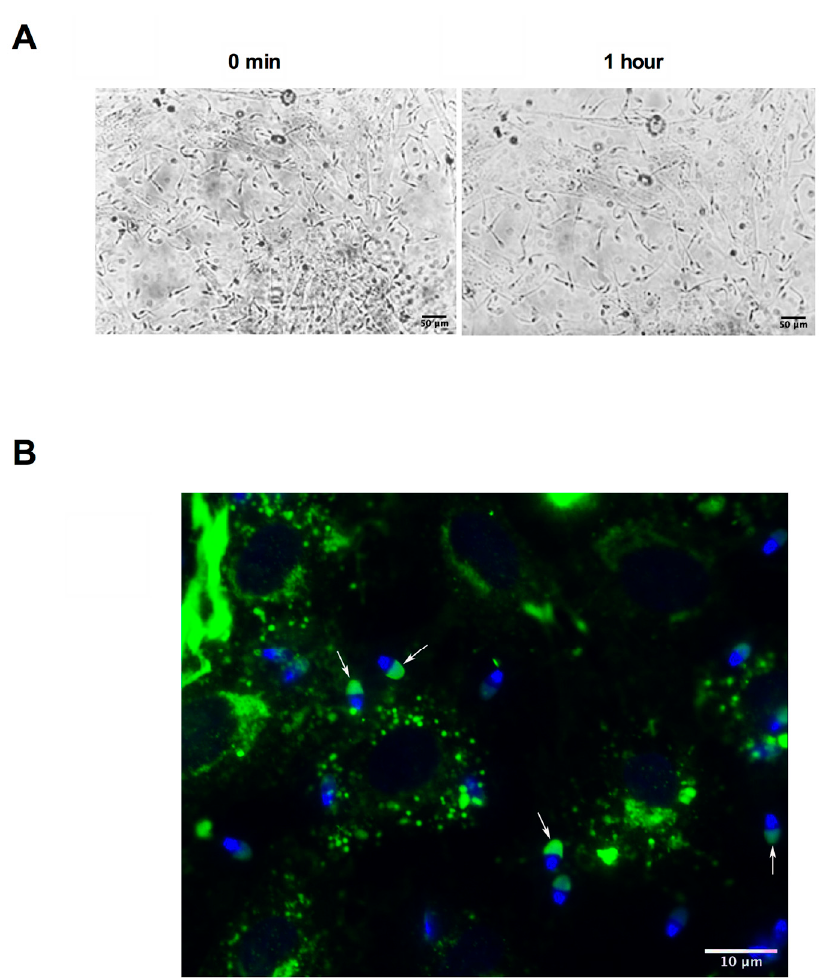
Figure 4. Characterization of cryopreserved semen bound to OEC primary cultures ( A ) Phase ‐ contrast representative images of cryopreserved equine sperm co ‐ cultured with OECs, 400× mag ‐ representative images of cryopreserved equine sperm co-cultured with OECs, 400 × magnification, nification, n = 6. Bar = 50 μ m. ( B ) Representative images of intact acrosomes (white arrows) exam ‐ n = 6. Bar = 50 µ m. ( B ) Representative images of intact acrosomes (white arrows) examined by ined by immunofluorescence 1 h after co ‐ culture with OECs stained with PSA ‐ FITC (green, acro ‐ immunofluorescence 1 h after co-culture with OECs stained with PSA-FITC (green, acrosome) and some) and Hoechst 33352 (blue, DNA). 1000× magnification, n = 3. Bar = 10 μ m. Hoechst 33352 (blue, DNA). 1000 × magnification, n = 3. Bar = 10 µ